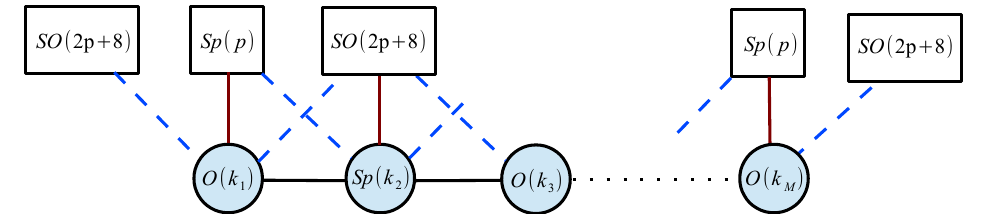
Figure 3 . Type IIA brane setup corresponding to M5 branes probing D p fundamental strings depicted as blue or red wavy lines in this (cid:12)gure give rise to (cid:12)elds in the 2d quiver theory.